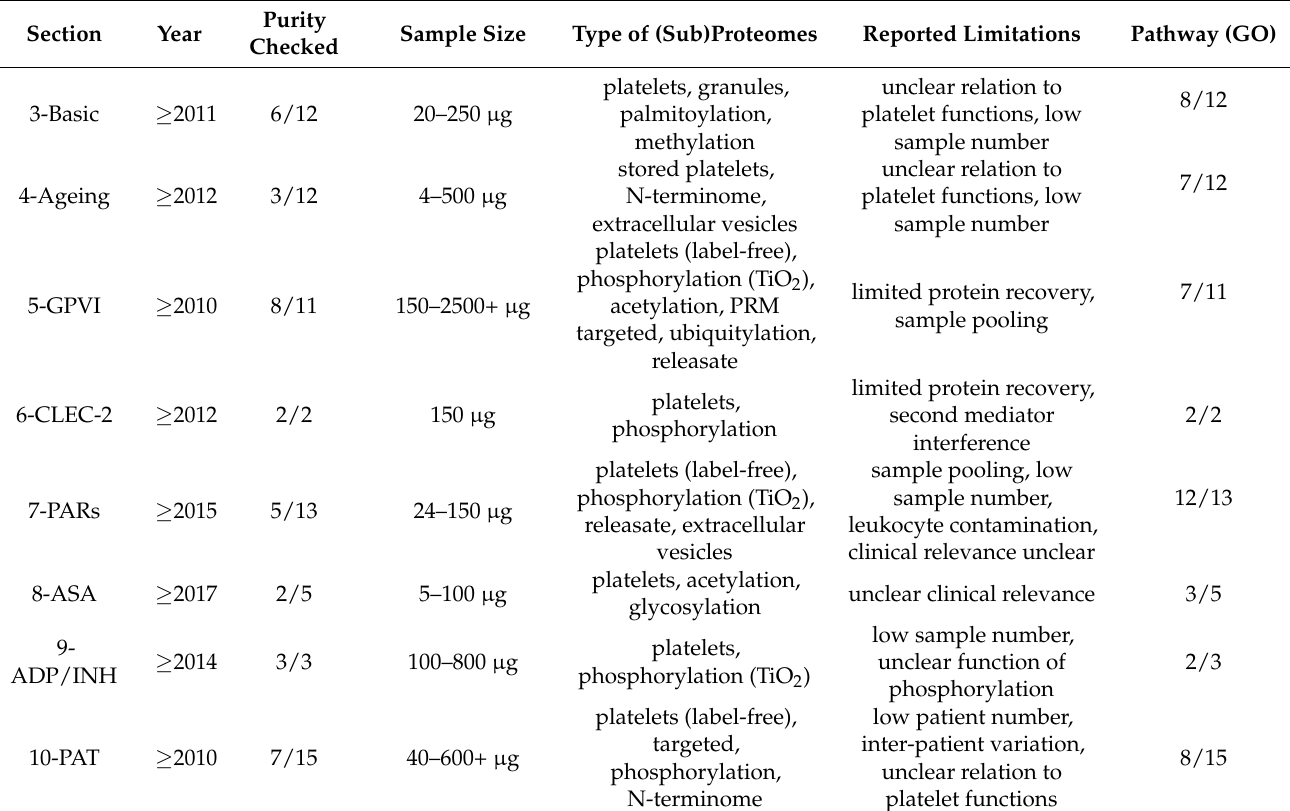
Table 1. Proceedings and characteristics per section of published proteomic studies regarding platelet purity, sample size, types of proteomes analysed and reported study limitations. For details per study, see Table S1. Abbreviation: PRM, parallel-reaction